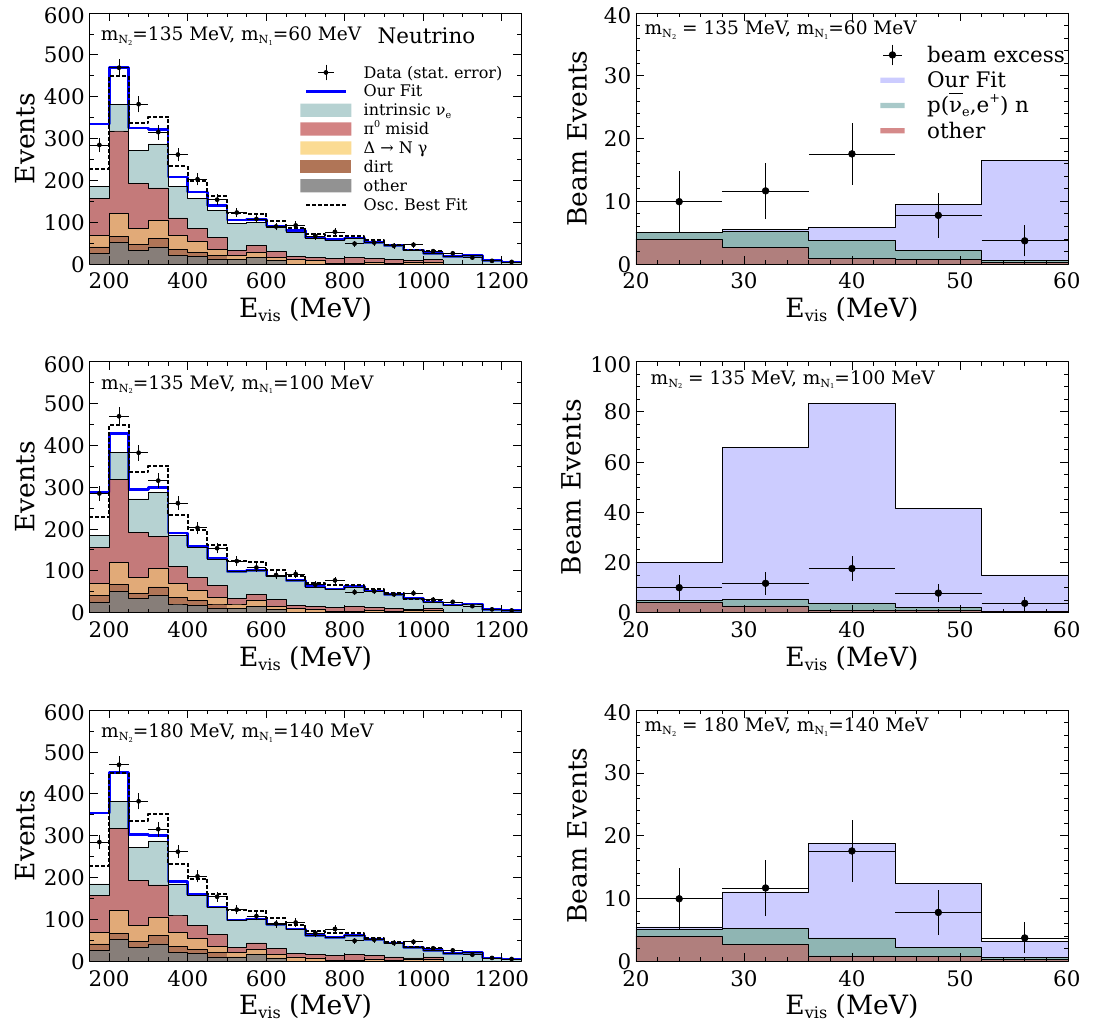
Figure 5. The left (right) column corresponds to the MB (LSND) events as a function of the visible energy, E . Various values of the masses of the daughter particle, m vis mass of the single scalar is fixed at 300 MeV for all panels while the mass of the decaying particle N 2 is assumed to be 135 MeV for the top and middle panels and 180 MeV in the bottom